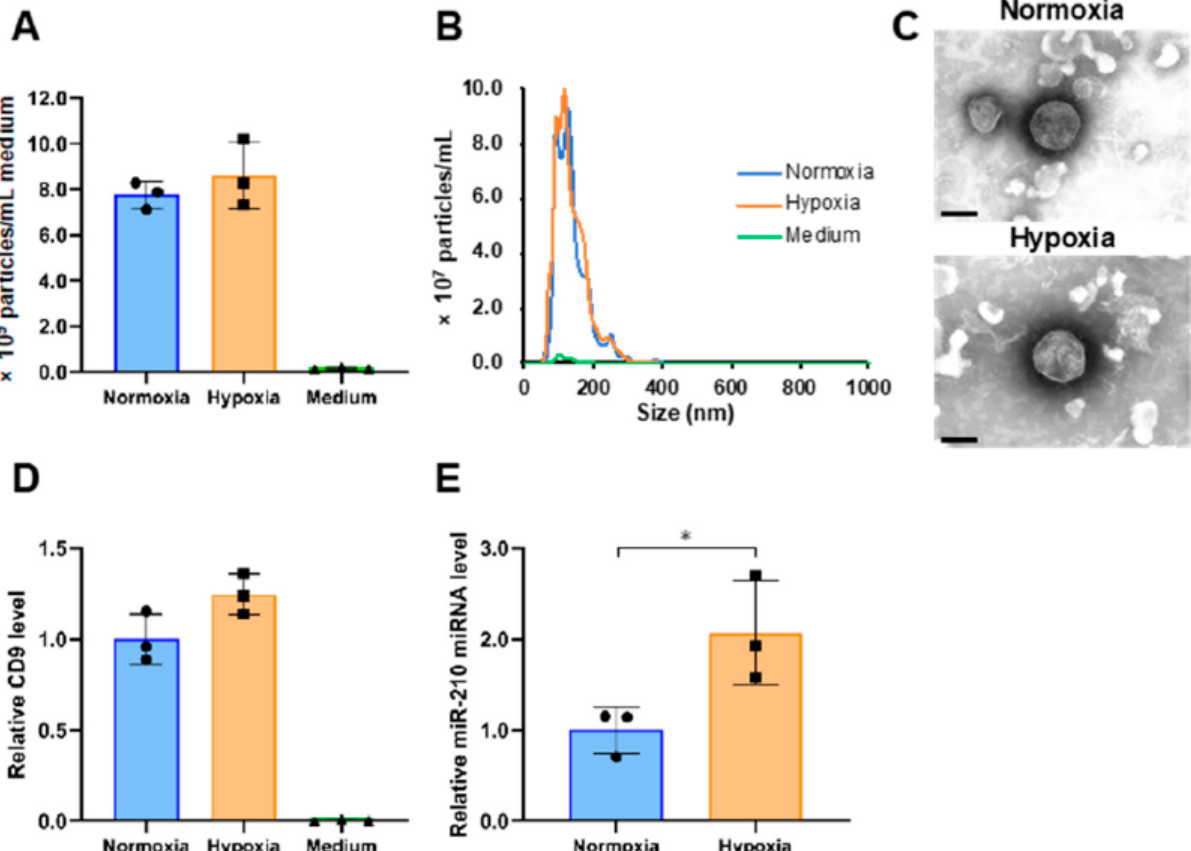
Figure 1. Characterization of small extracellular vesicles (sEVs) derived from PANC-1 cells cultured under different oxygen concentrations. ( A ) The number of particles in normoxia, hypoxia, and medium samples. ( B ) Particle size distribution in normoxia, hypoxia, and medium samples. ( C ) Transmission electron microscopic images of sEVs under normoxia and hypoxia. Scale bar, 100 nm. ( D ) The relative expression levels of CD9 in normoxia, hypoxia, and medium samples. ( E ) The expression level of miR-210 in normoxia and hypoxia samples. The expression data were normalized to the number of particles. Symbols indicate the result of each sample, and the bar graphs indicate the mean ± SD ( n = 3). The Student’s t -test was used to determine the statistical significance. * p <